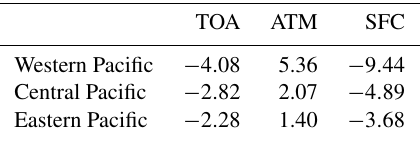
Table 1. Annual mean radiative forcing of aerosols simulated by WRF-Chem for 2010–2014 over three regions shown in Fig. 2. Neg- ative values represent downward radiation. Units: Wm − 2